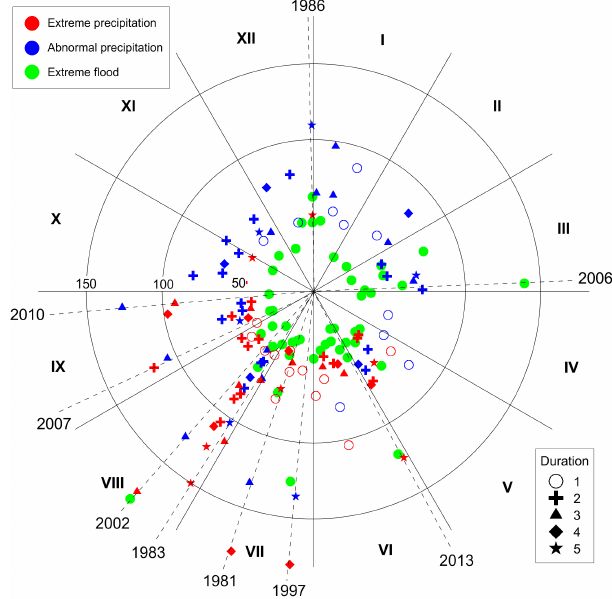
public, 1961–2010. EPEs were evaluated using the WEI (red), APEs using the WAI (blue), and EFEs using the FEI (green). Values of the indices are depicted by the distance of symbols from the center of the diagram. The shape of symbols depicts how many days the pre- cipitation event